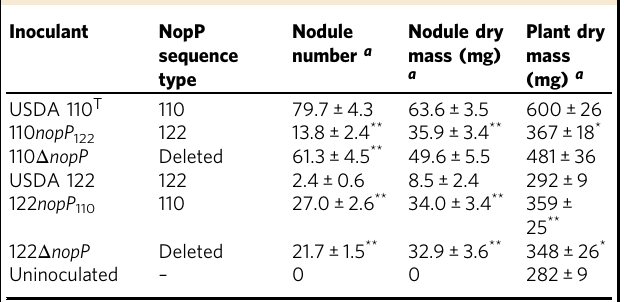
Table 1 Symbiotic phenotypes of V. radiata cv. KPS1 inoculated with wild-type B. diazoef fi ciens strains and their nopP mutants